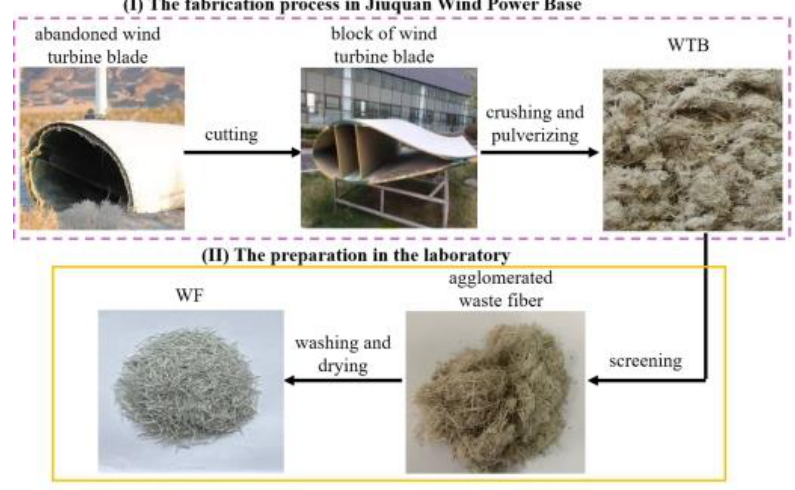
Figure 1. The preparation process of the waste glass